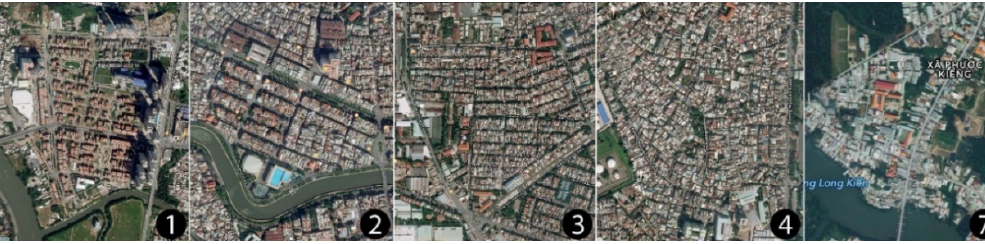
Figure 4. Examples of urban structure pattern types in the study (( 1 ) pattern type 1; ( 2 ) pattern type 2; ( 3 ) pattern type 3; ( 4 ) pattern types 4, 5, and 6; and ( 7 ) pattern type 7) (source: Map data ©2018 Google).